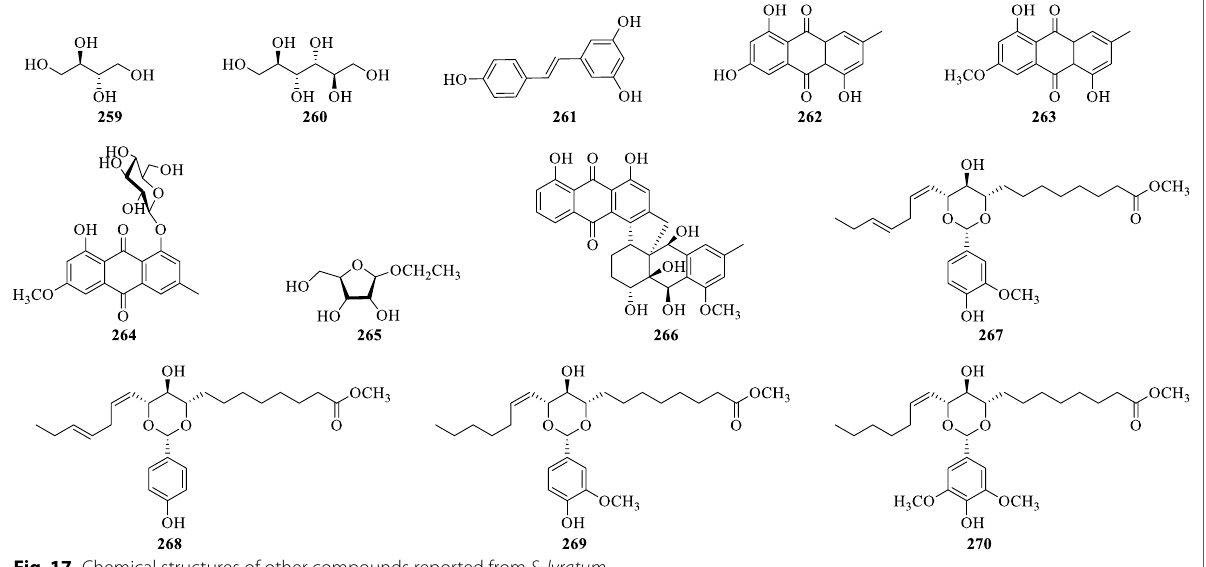
Fig. 17 Chemical structures of other compounds reported from S.